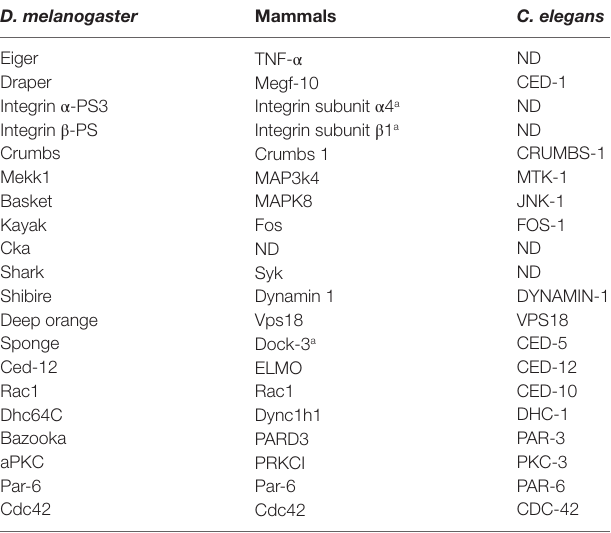
TAble 3 | Required engulfment machinery in Drosophila follicular epithelium and orthologs. a D.